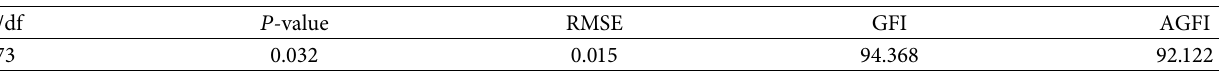
Table 3: Goodness of fit indices of corporate governance.